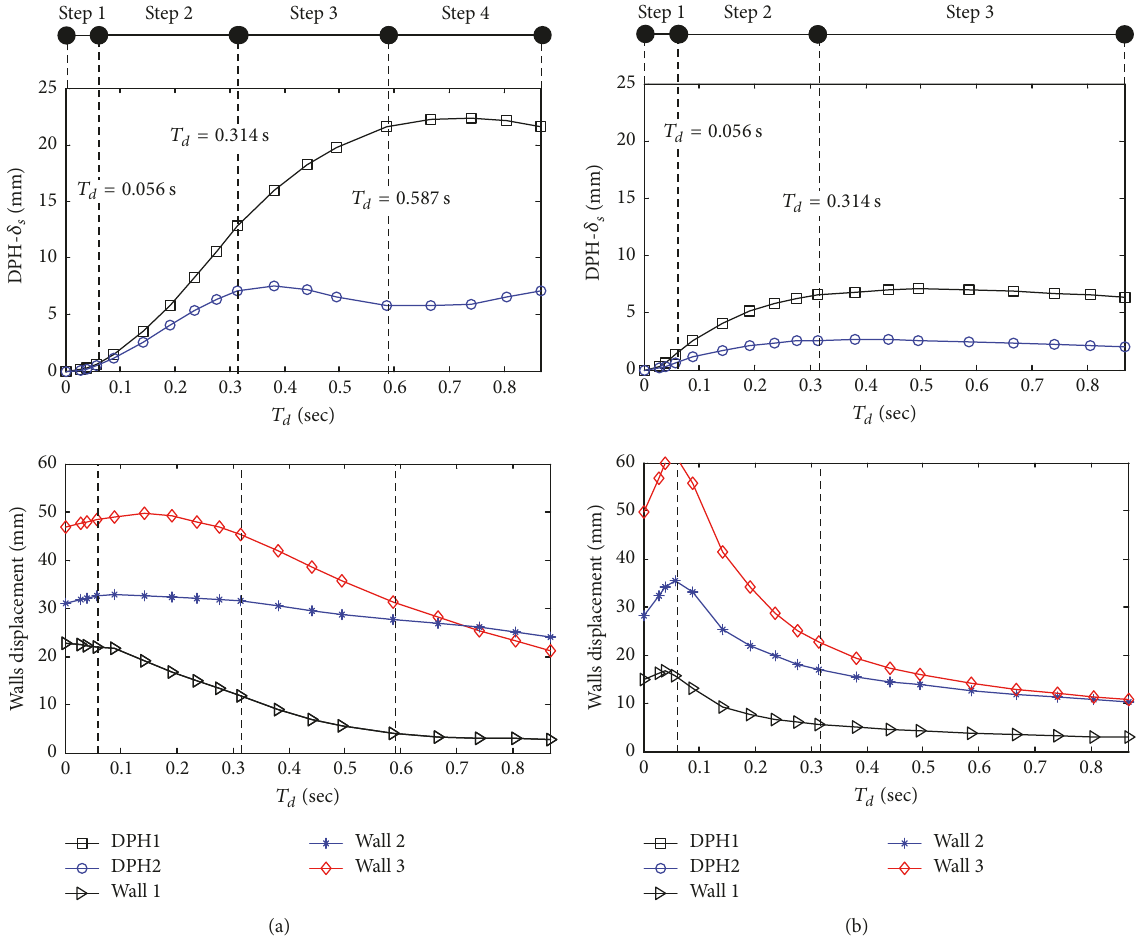
Figure 11: Qualitative classification of the asymmetric structures behavior for model 8 in DBE earthquakes: (a) inelastic and (b) elastic.